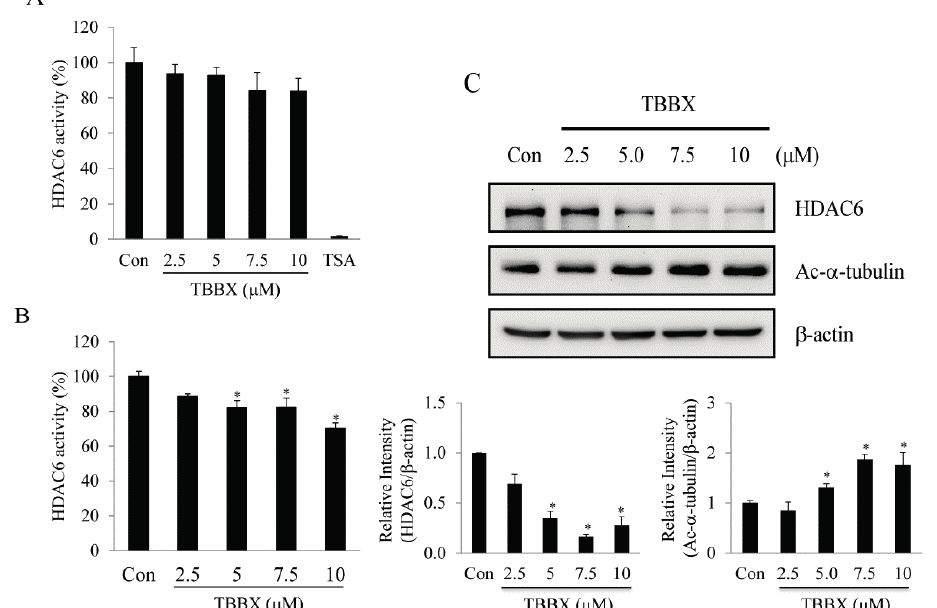
Figure 7. Effect of TBBX on class IIb HDAC6 activity and protein expression in H1299 lung cancer cells . ( A ) Nuclear extracts containing HDAC6 enzymes were incubated with various concentrations of TBBX (0, 2.5, 5, 7.5 and 10 μ M) and HDAC6 activity assay was determined as described in Materials and Methods. The trichostatin A (TSA, 2 μ M) were examined as positive control. ( B ) H1299 cells were incubated with various dosage of TBBX (0, 2.5, 5, 7.5 and 10 μ M) for 24 h. Cells were harvested and HDAC6 activity was determined as described in Material and Methods. ( C ) H1299 cells were treated with various dosage of TBBX (0, 2.5, 5, 7.5, and 10 μ M) for 24 h. After treatment, cells were harvested and Western blot was done by anti-HDAC6, acetyl-tubulin and anti- β -actin antibodies. Data were the mean ± S.D. of triplicate samples. Significant difference was observed from the control group (* p <